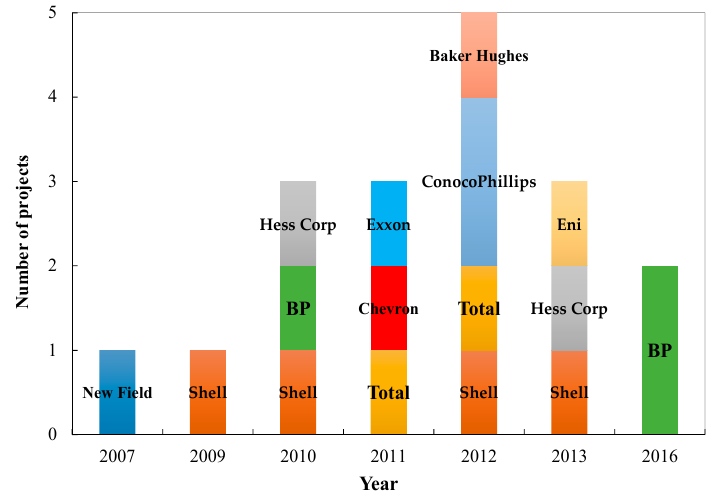
Figure 4. International cooperation in China’s shale gas industry boomed in 2010, and reached a peak in 2012.